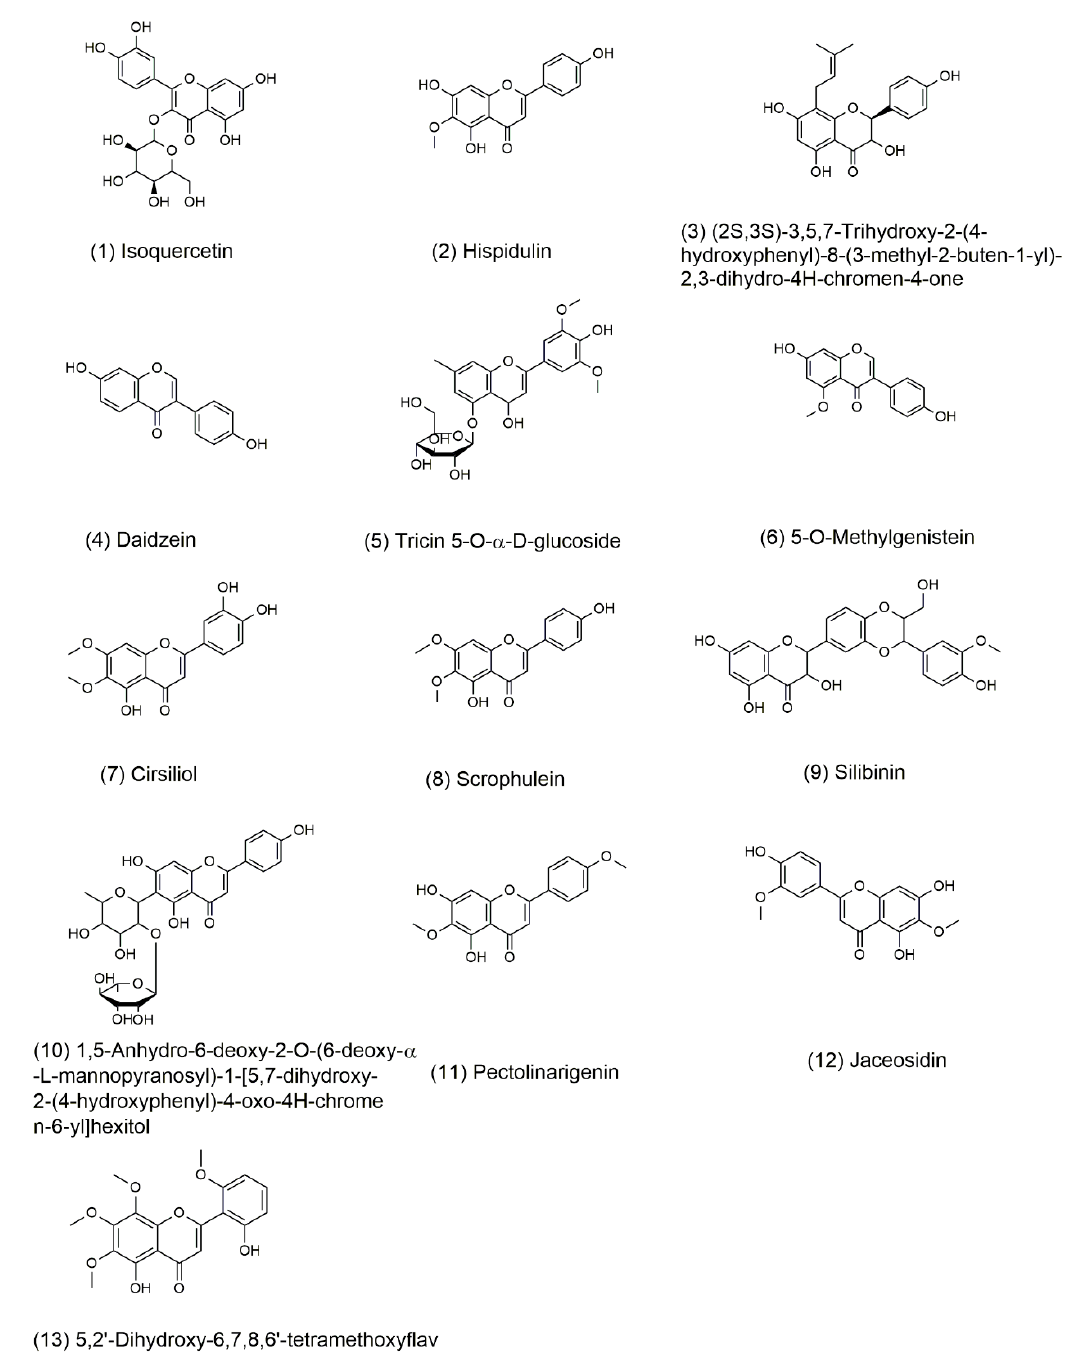
Figure 5. Structure of major flavonoids recognized from fraction B of TFSR by UHPLC-HRMS/MS.